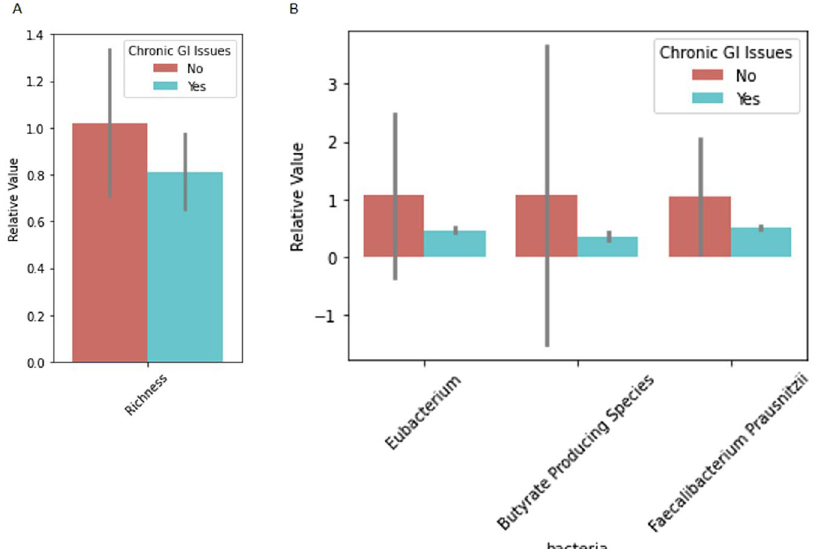
Fig. 5 Relative value of microbiome features that differed by if the dog had recurrent gastrointestinal (GI) illness or not (only associations signi fi cant via Mann – Whitney test, p < 0.05 are included). A Re fl ects differential value of richness, and B re fl ects relative abundance. Error bars represent con fi dence intervals.